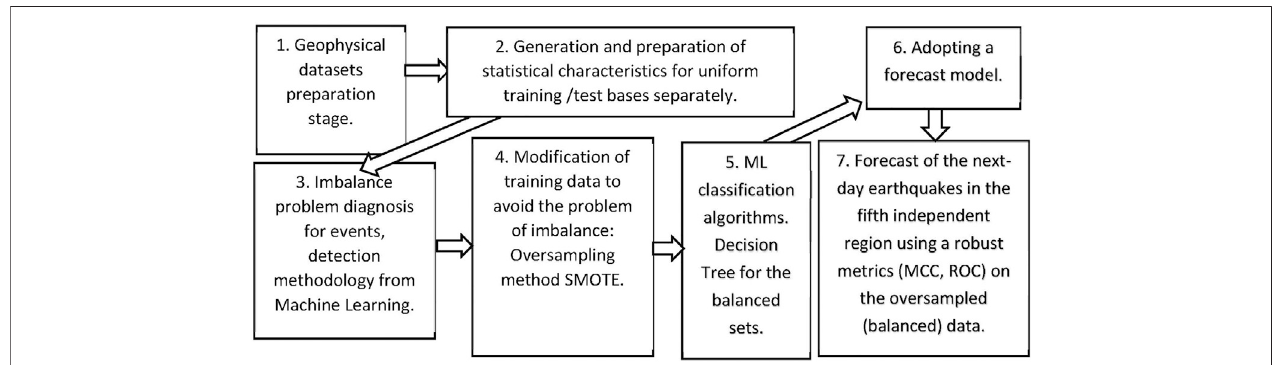
FIGURE 4 | Scheme of the used machine learning